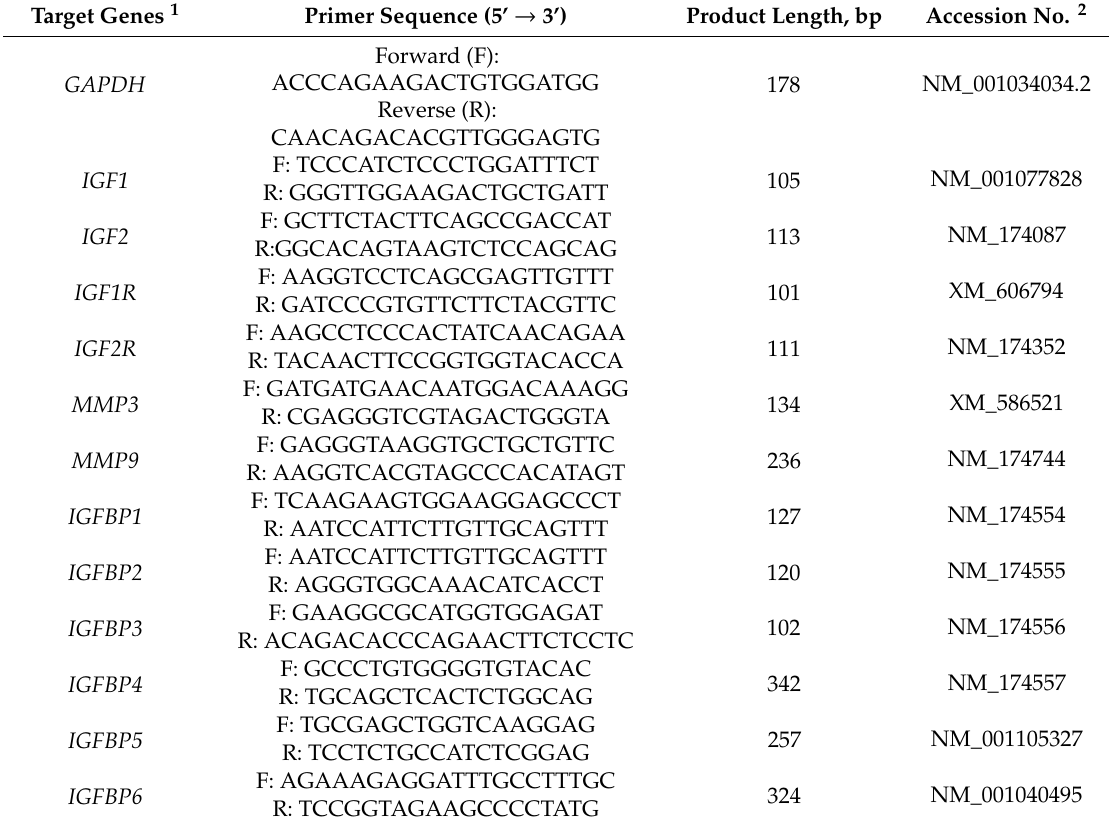
Table 2. The primer sequence of the target